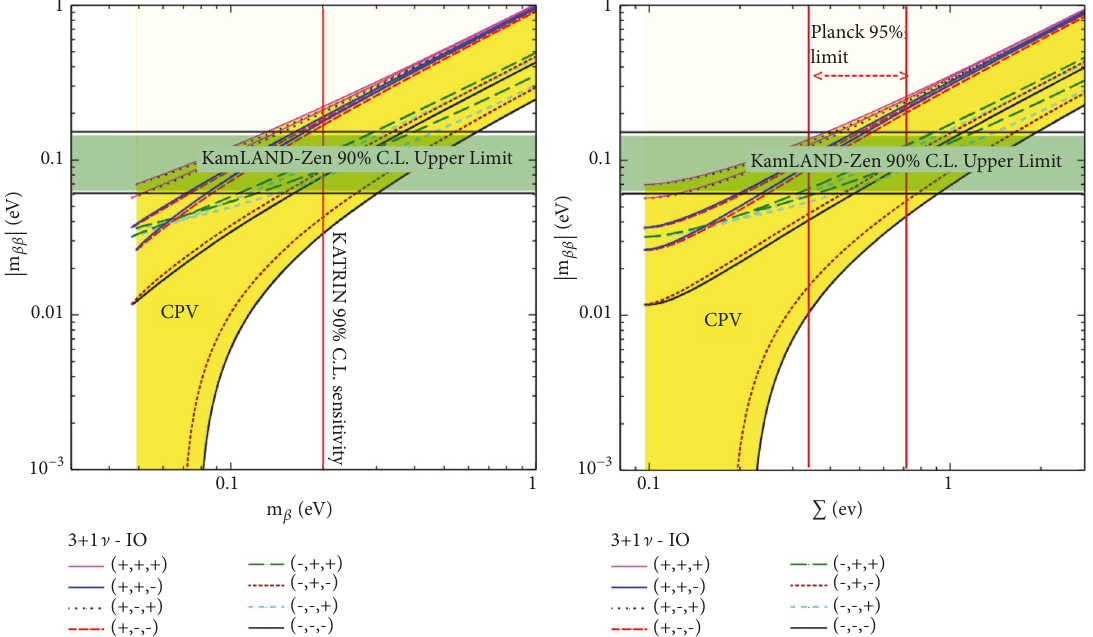
Figure 3: Left and right panel, respectively, show the value of effective Majorana mass |𝑚 𝛽𝛽 | as a function of effective electron neutrino mass 𝑚 ∑ in the case of 3+1 neutrino mixing with Inverted Ordering. The signs combination as shown in the 𝛽 and sum of the neutrino masses legend implies the signs of 𝑒 𝑖𝜙 21 ,𝑒 𝑖𝜙 31󸀠 ,𝑒 𝑖𝜙 41 = ± 1 for the eight possible cases in which CP is